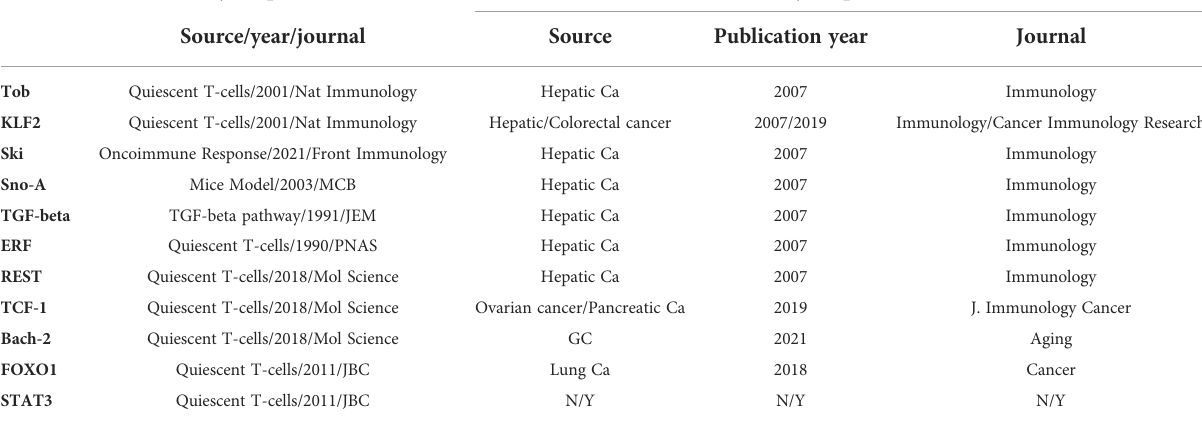
TABLE 1 Higher expression genes from quiescent